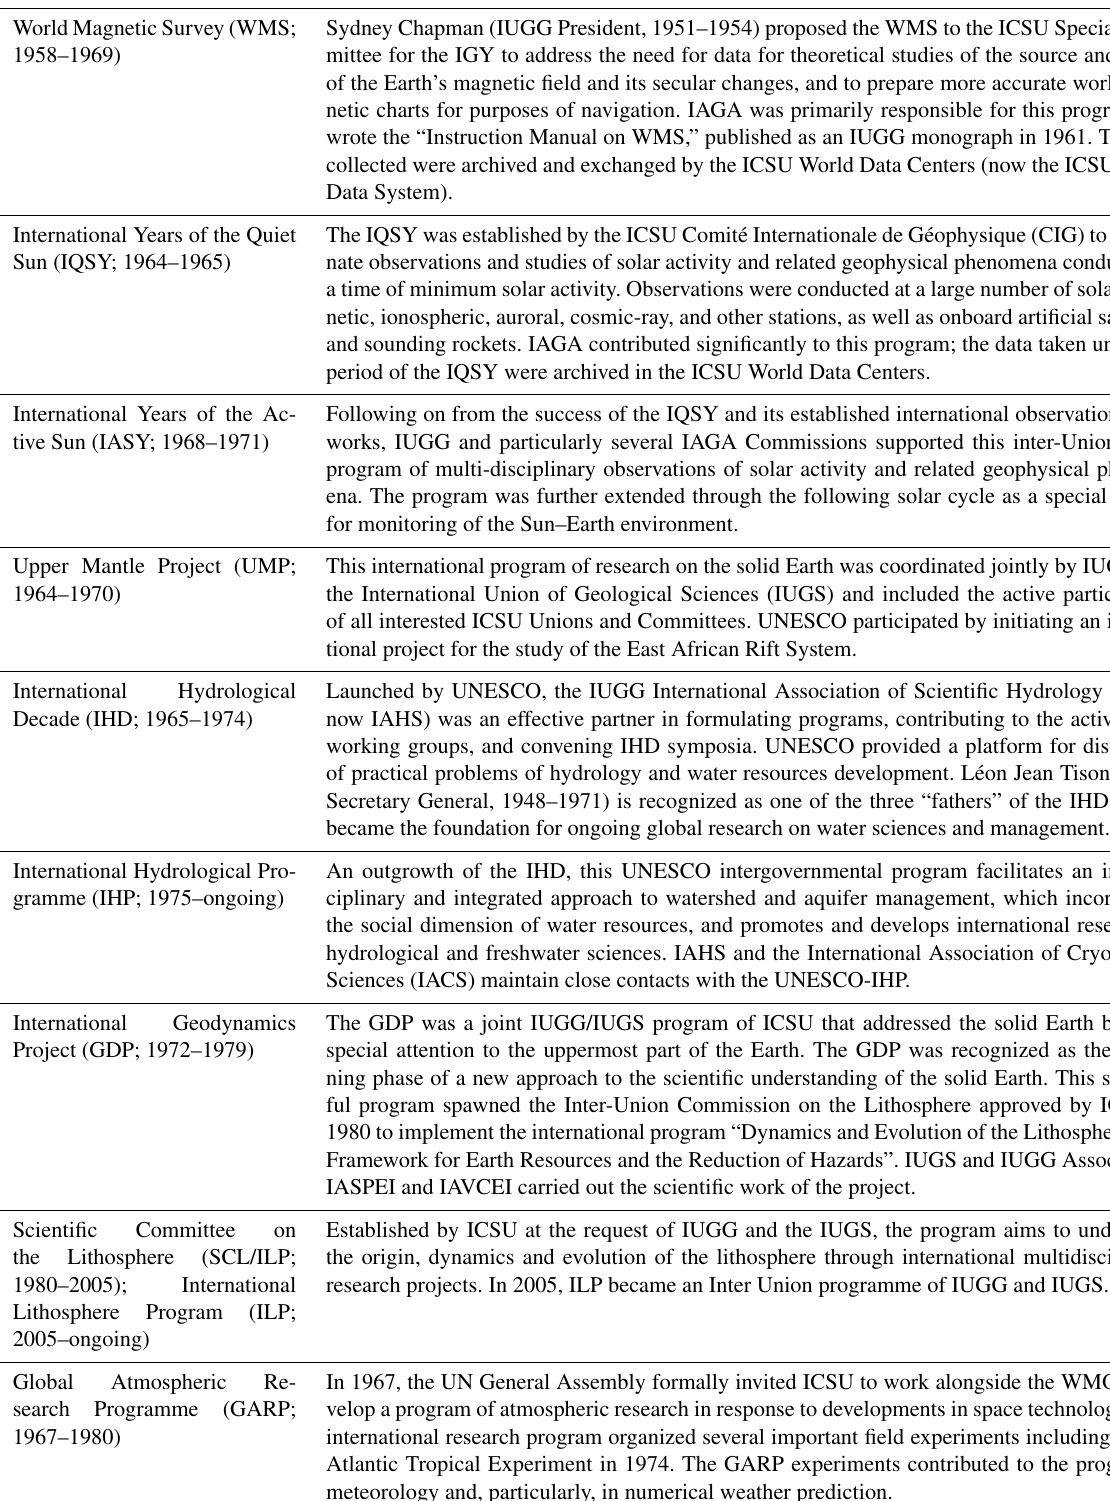
Table 1. International Scientific Programs and IUGG involvement. World Magnetic Survey